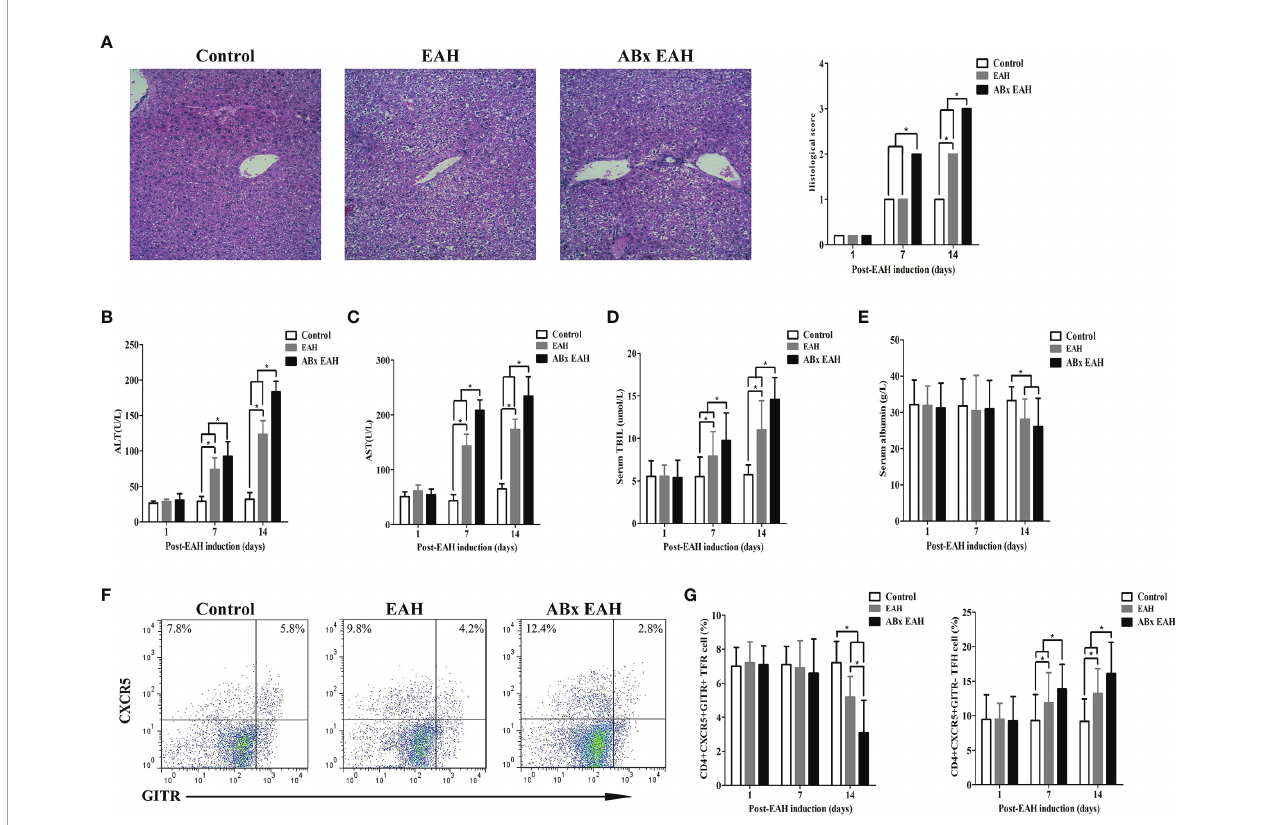
FIGURE 2 | Flow cytometry of TFR/TFH cells in SMNC. Fifteen mice ( fi ve from the EAH group, fi ve from the ABxEAH group, and fi ve from the control group) were killed at each time point (1, 7, and 14 days). (A) Representative histological picture of liver lesions in animals after standard induction of ABx-EAH, EAH, and controls on the 14th day (magni fi cation, 200×); (B – E) the levels of serum ALT, AST, TBIL, and ANA in mice after standard induction of ABx EAH and EAH mice with S100 and control mice with PBS; (F) fl ow cytometry analysis of TFR and TFH cells from the spleen on the 14th day; (G) percentages of TFR and TFH cells at each time point from ABx EAH, EAH, and control mice were analyzed by FACS. The horizontal lines indicate the mean values of the different groups. *p <